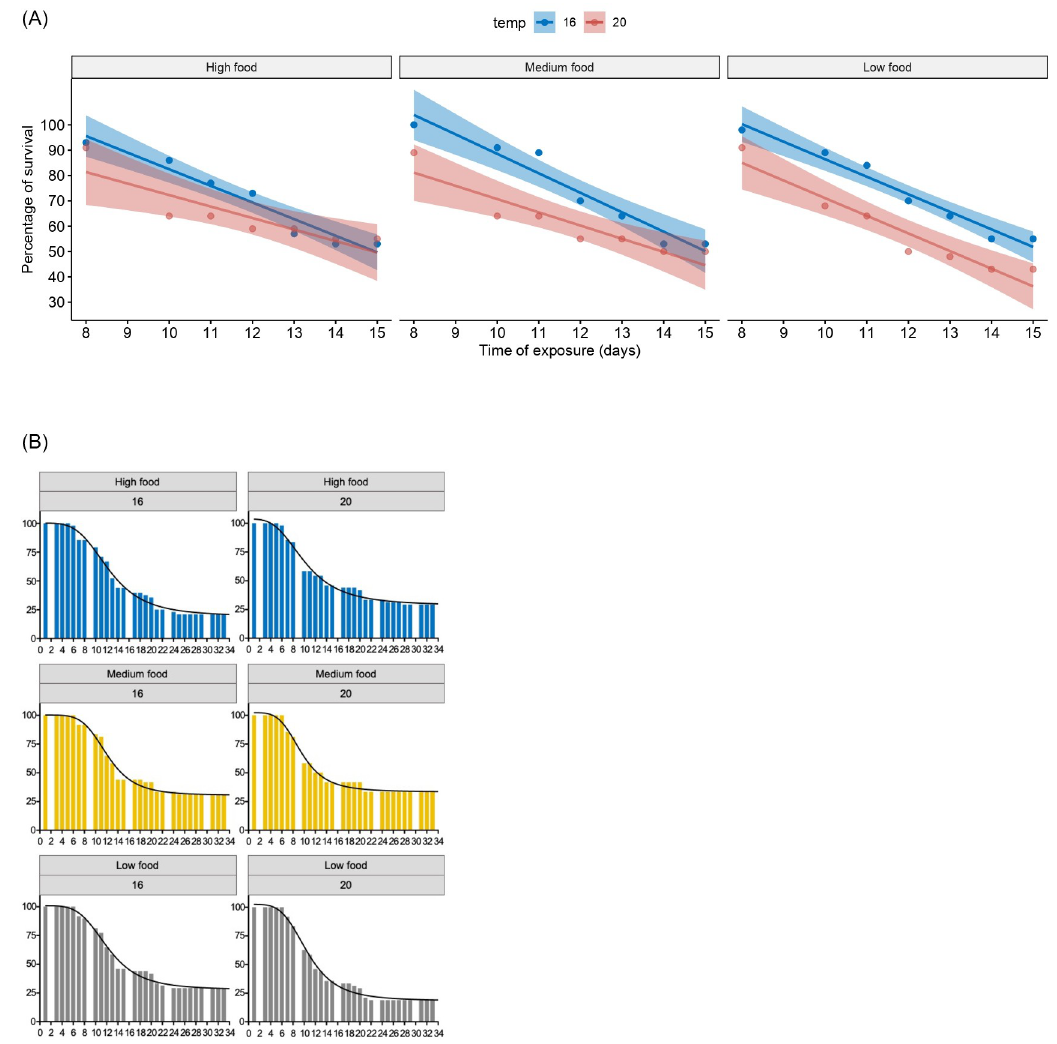
Fig 3. Larvae survival during the experiment. Percentage of survival with fitted four parameter logistic regressions in S . solea according to the feeding frequency at two different temperatures. a: whole experiment duration (33 days larvae aged 35 dph). b: Solid lines represent linear models fitted to the to the second’s week percentage of survival with 95% confidence level intervals (shadow area).